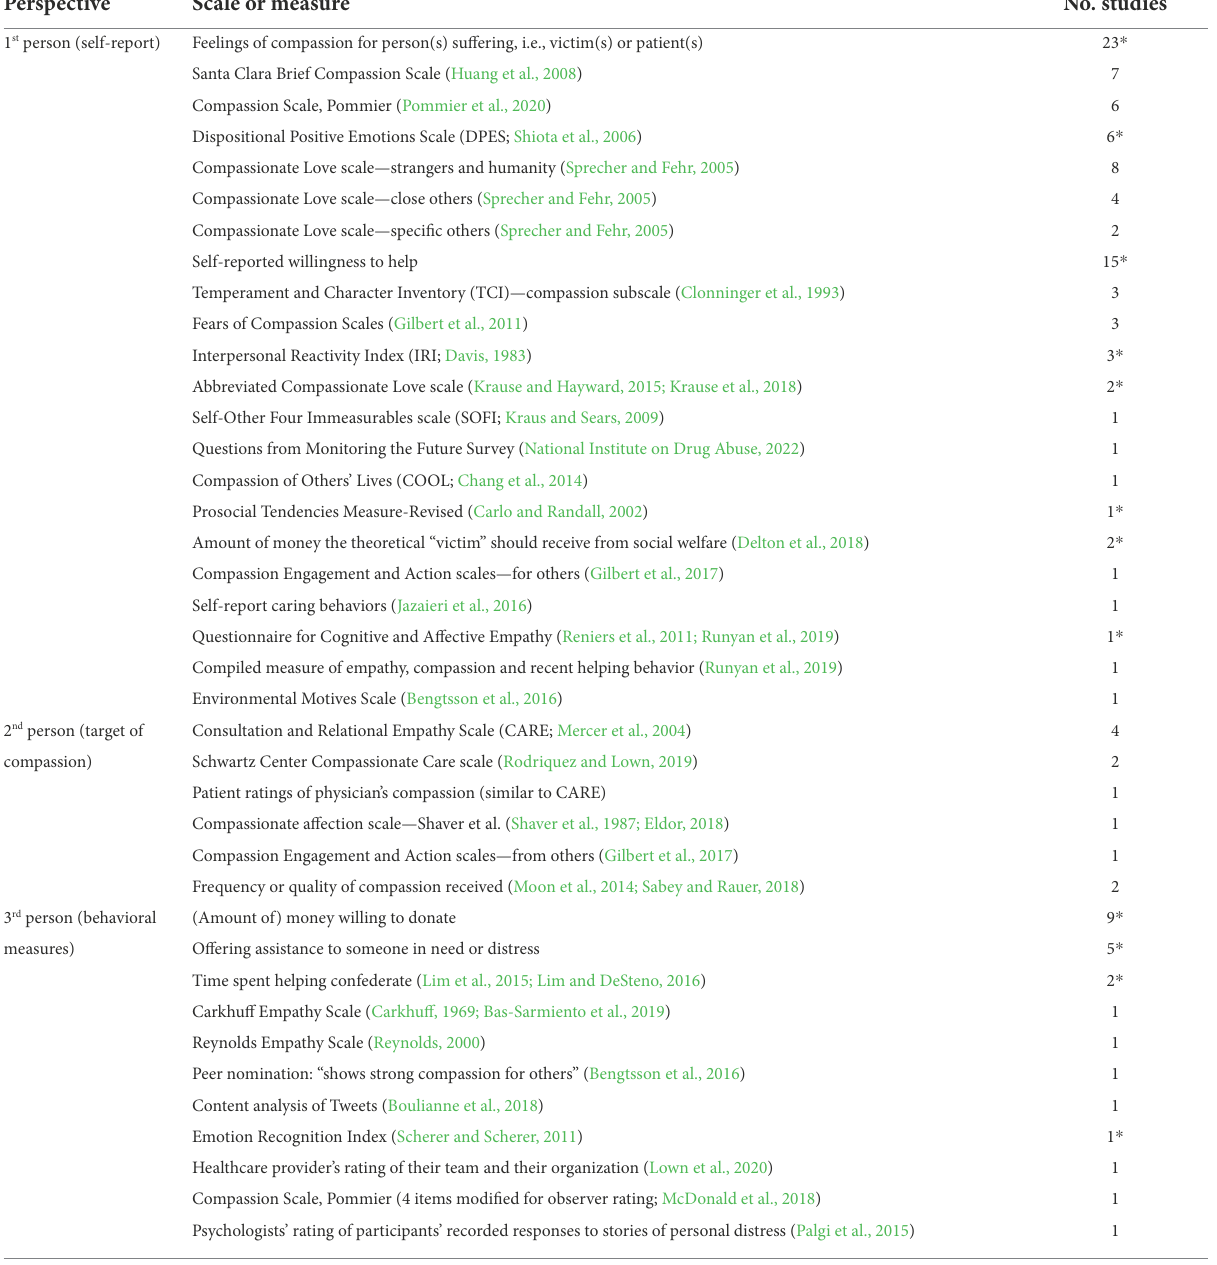
TABLE 2 Measures used to assess compassion in 82 studies examining compassion as an